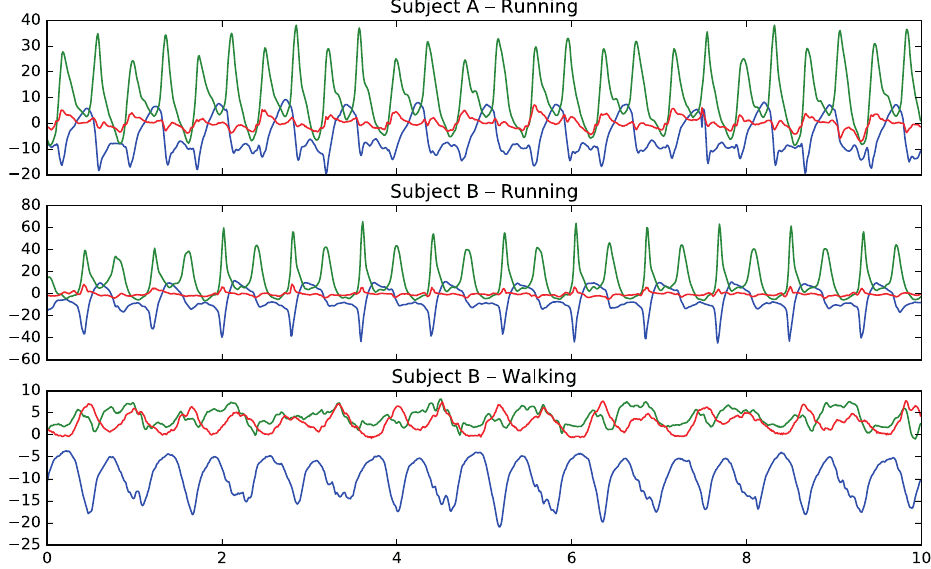
Figure 3. Information from the accelerometer sensor for 2 different activities (running and walking). The unit of the vertical axis is m/s 2 . The colors are blue ( x ), green ( y ) and red ( z